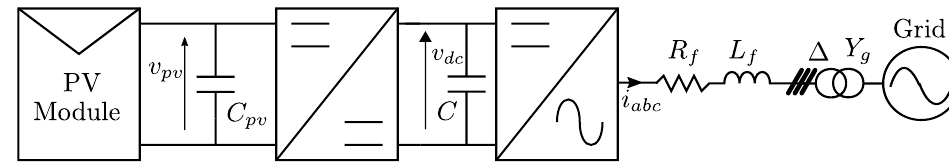
Figure 3. Two-stage connection of a PV module to the electric